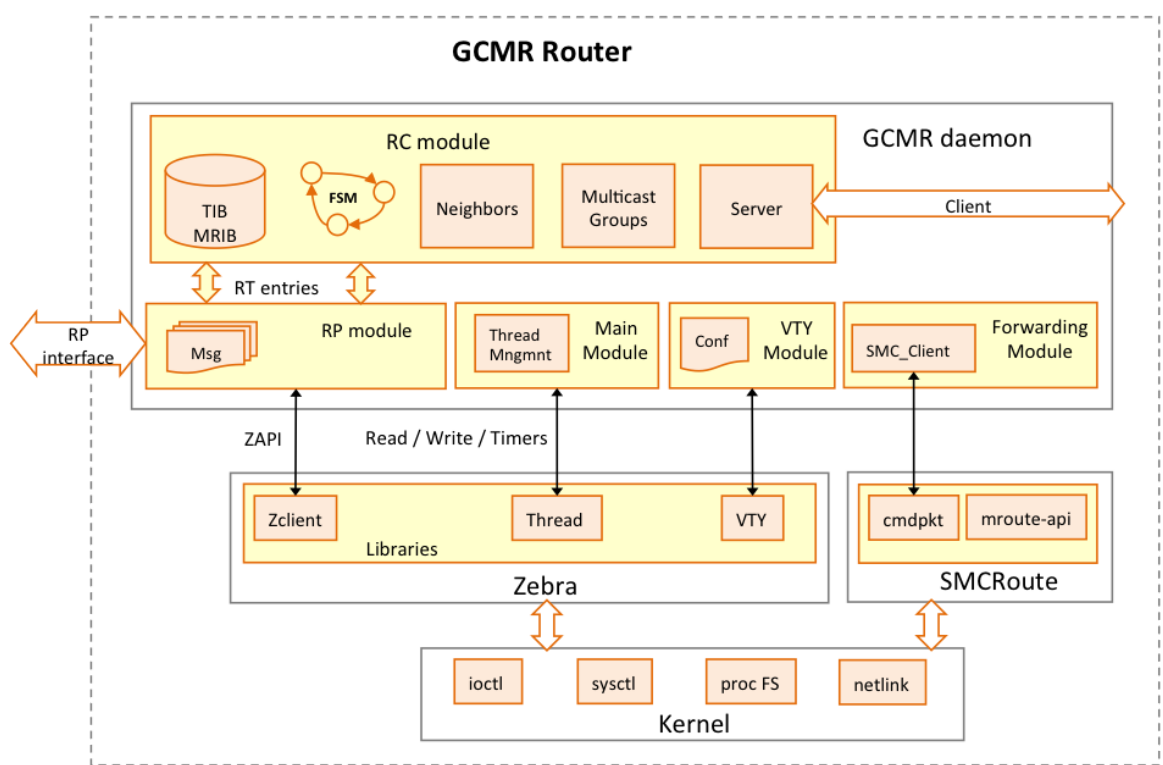
Figure 6. The GCMR node